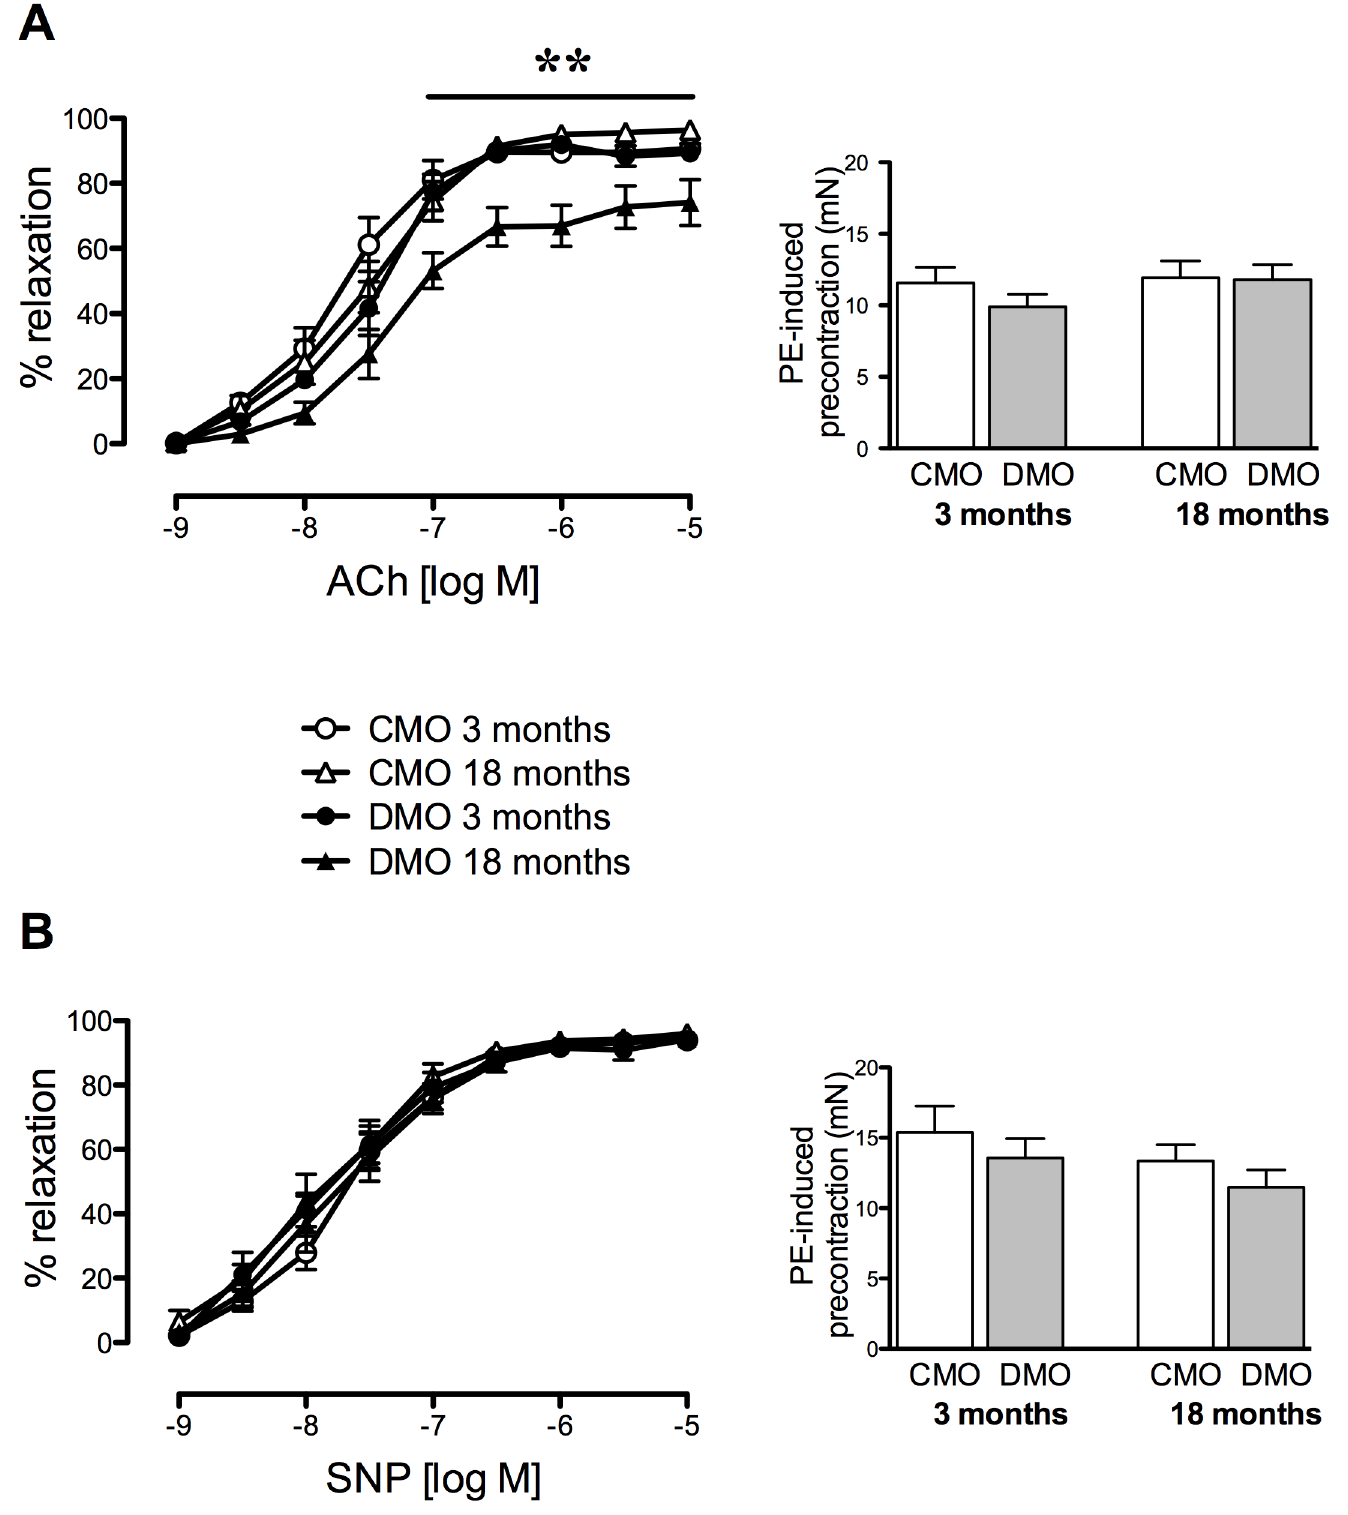
Fig 1. Vascular relaxation of mesenteric arteries in control (CMO) and diabetic (DMO) mother offspring. Concentration-response curve to acetylcholine (ACh, A) and sodium nitroprusside (SNP, B). Bar graphs represent the level of pre-contraction induced by 10 -6 M phenylephrine. Values are mean ± SEM (n = 7 minimum per group). * p < 0.05 and ** p < 0.01 DMO vs. CMO.